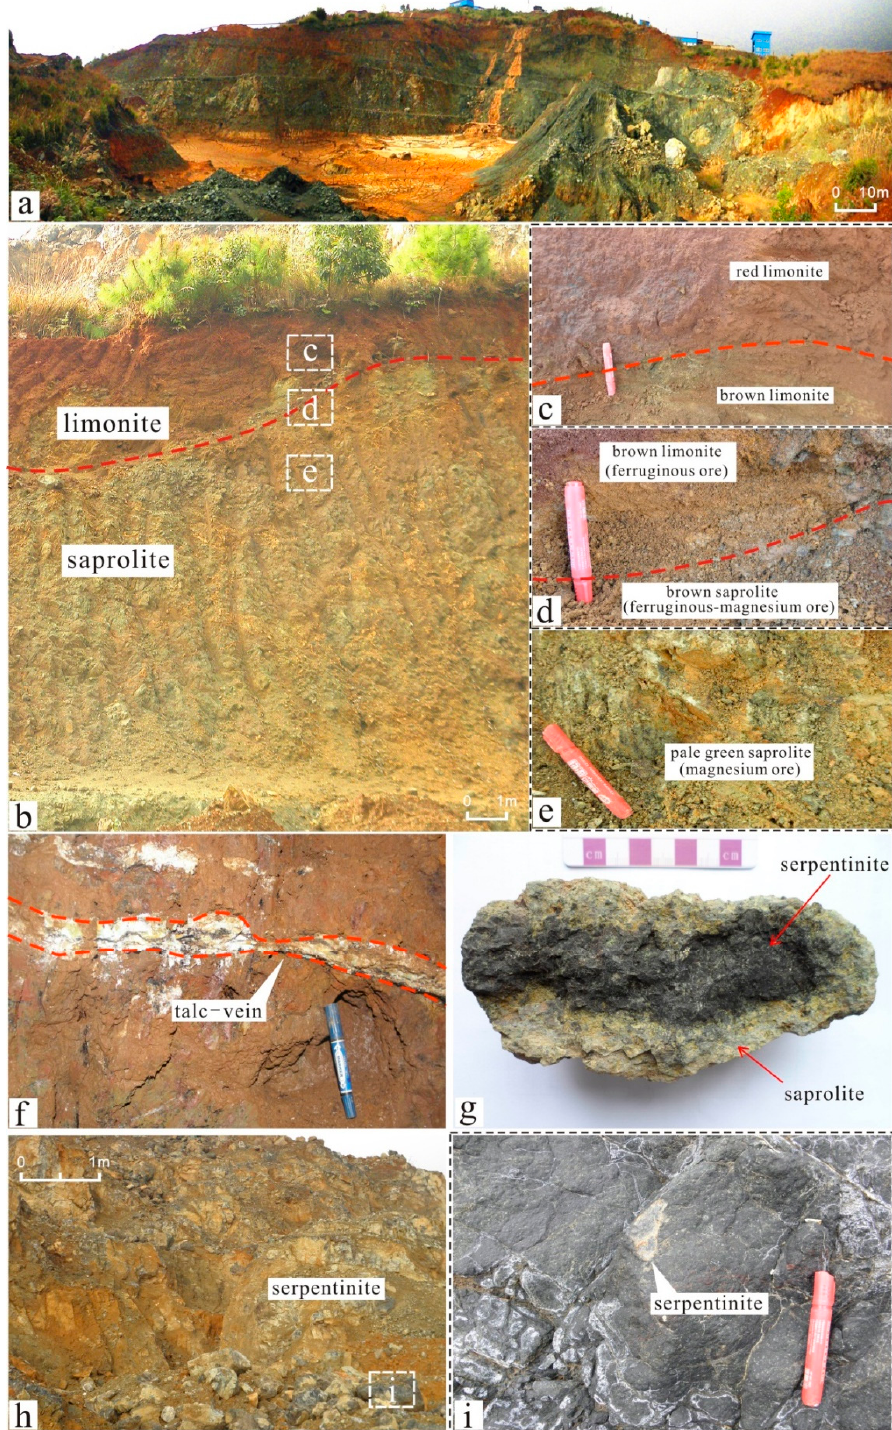
Figure 2. Macrophotographs of the lateritic Ni profile at the Yuanjiang area, showing its field geological characteristics: ( a ) lateritic regolith at the III-level denudation plane; ( b ) a typical lateritic Ni profile showing the divided regolith units; ( c ) the boundary of red limonite and brown limonite; ( d ) the boundary of brown limonite and brown saprolite; ( e ) the pale green saprolite developed in the middle and lower part of the profile; ( f ) the residual talc-vein in the saprolite horizon; ( g ) a typical rocky saprolite showing a black bedrock core surrounded by green saprolite; ( h ) outcrop of the bedrock exposed by mining; and ( i ) fresh serpentinite in the bedrock.